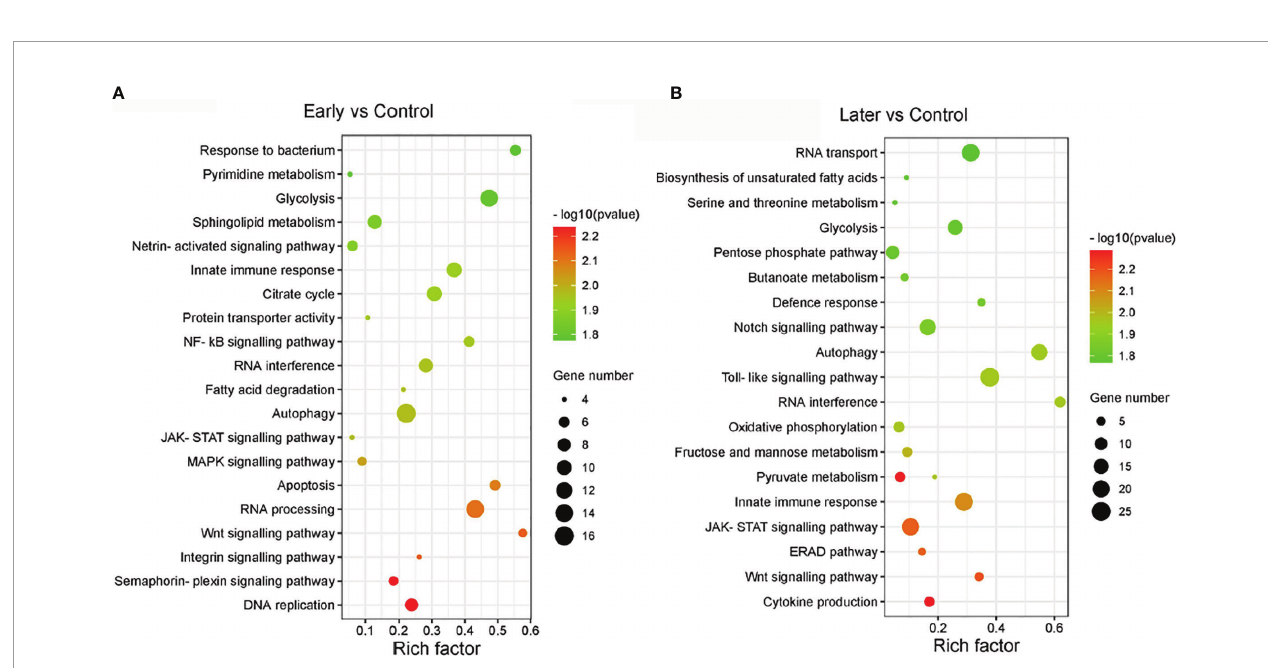
FIGURE 3 | GO analysis of differentially expressed lncRNAs. (A, B) GO annotations based on the target genes of differentially expressed lncRNAs by co-location analysis, (A) between uninfected and early infected group, (B) between uninfected and later infected group. Different colors were used to distinguish functional category, red columns represented biological process (BP), blue columns represented molecular function (MF), green columns represented cellular component (CC). Only annotations with a signi fi cant P-value of < 0.01 were